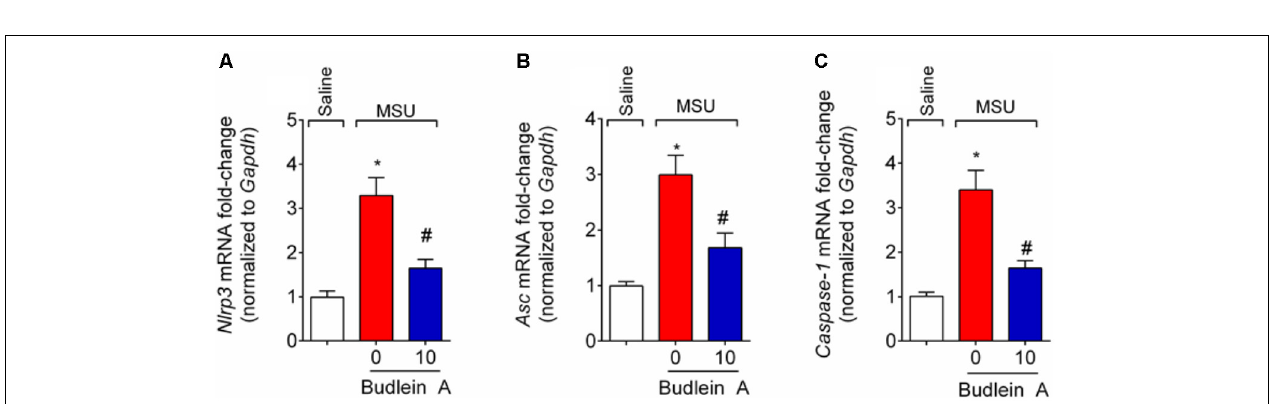
FIGURE 6 | Budlein A inhibits MSU-induced inflammasome assembly. Fifteen hours after the injection of MSU crystals, knee joint was dissected for the determination of Nlrp3 (A) , Asc (B) , and Caspase-1 (C) mRNA expression by RT-qPCR. ∗ p < 0.05 vs. saline group; # p < 0.05 vs. 0 mg/kg group, one-way ANOVA followed by Tukey’s post hoc